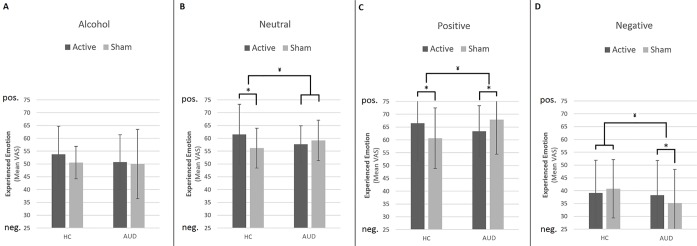
Effect of repetitive transcranial magnetic stimulation (rTMS) on experienced emotion. This figure shows the differential effects of rTMS and sham stimulation on experienced emotion in reaction to alcohol (A), neutral (B), positive (C), and negative (D) images. Note that a value of 50 represents “neutral” experienced emotion. Bars represent estimated marginal means, which are corrected for experienced emotion before rTMS. Error bars are standard deviations from the mean. ¥ = significant two-way interaction (group by stimulation), * = significant main effect of stimulation within participant group, pos. = positive, neg. = negative.